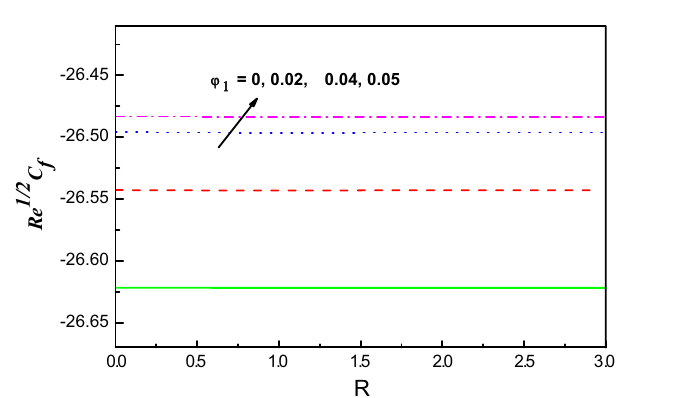
Figure 16. Re 1 / 2 C f Variation vs. R with ϕ 1 .